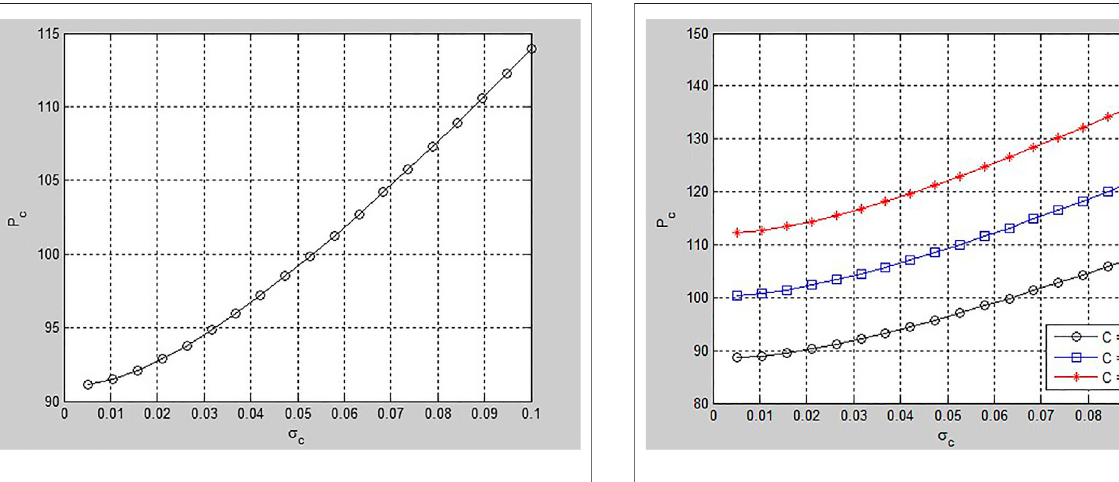
FIGURE 4 | Curve of [ P p c − σ c ] FIGURE 5 | Curve of [ P p c − C